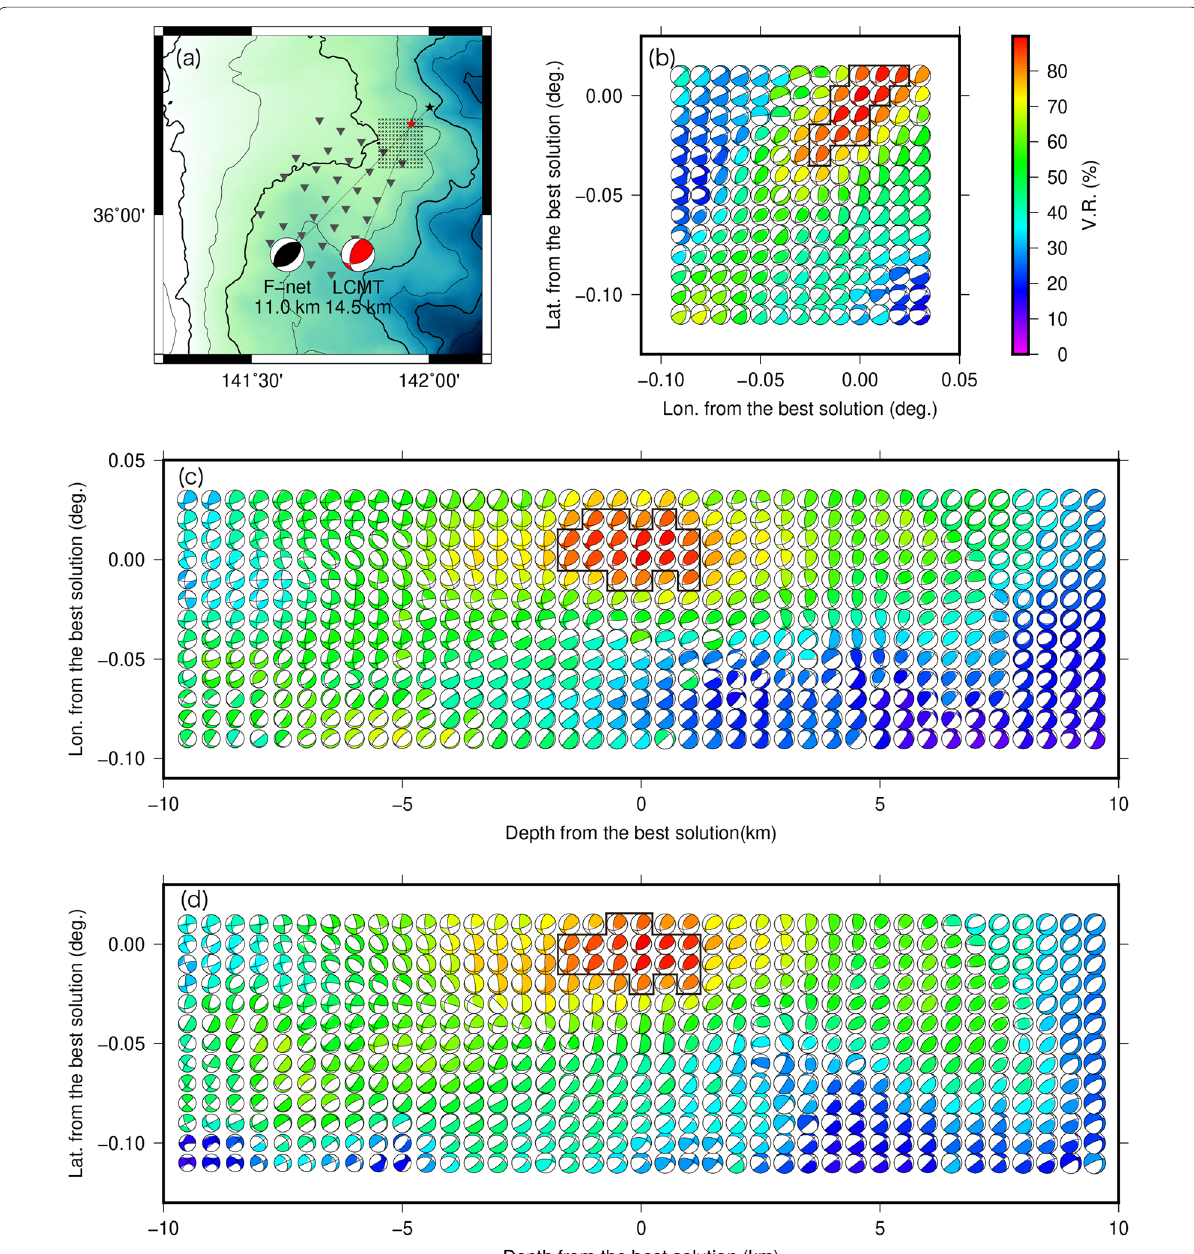
Fig. 3 Result of the CMT inversions for the earthquake ( M w 4.0 ) that occurred at 9:06, March 16, 2011 (JST). a Centroid location of the earthquake and the OBS array. The red star shows the horizontal location of the best centroid with 14.5 km depth. The red focal mechanism shows the moment tensor of the best CMT solution. The black star indicates the horizontal location of the F-net MT solution with 11.0 km depth. The black focal mechanism shows the moment tensor of the F-net MT solution. The grey triangles show the stations of the OBS array. b Horizontal resolution of the CMT solution. The color of the focal mechanisms shows the VR. The region surrounded by the black line shows VR more than 90% from our best. c Depth resolution with longitudinal direction, and ( d ) with latitudinal